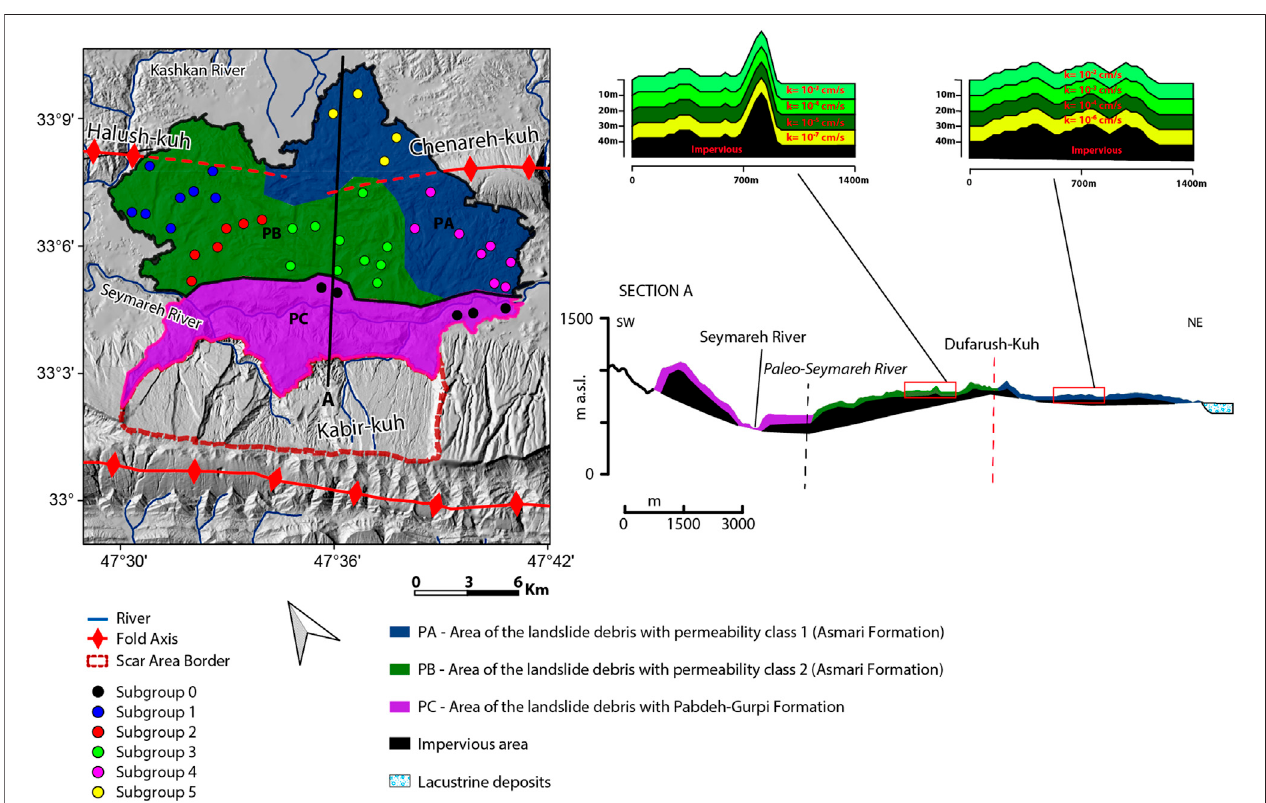
FIGURE 10 | Permeability class map based on the laboratory tests performed on the fi ve subgroups of ML debris matrix samples whose results are reported in Figure 7 ; Table 3 . The coordinate reference system is WGS84. A permeability section obtained in the landslide debris is also shown.